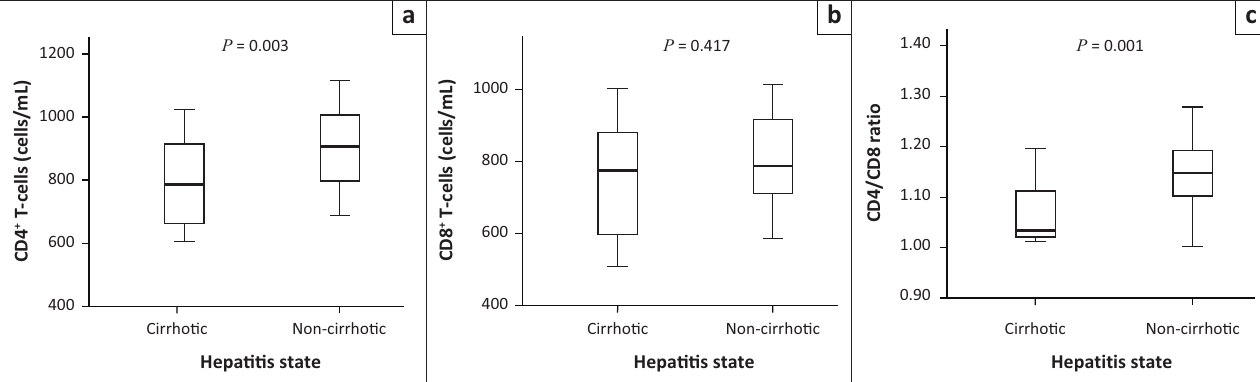
FIGURE 1: Level of CD95 and CD95L in cirrhotic and non-cirrhotic hepatitis B virus-positive patients at Yaoundé General Hospital, Cameroon, September–December 2018. a